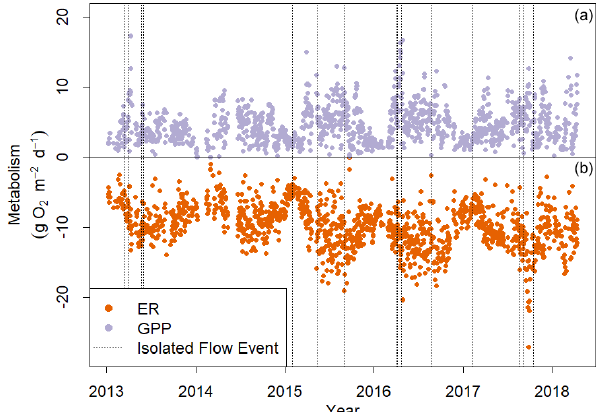
Figure 4. Gross primary production (GPP, a ) and ecosystem res- piration (ER, b ) in Stroubles Creek, VA, from 8 January 2013 to 14 April 2018. ER is represented here as a negative rate because it is the consumption of oxygen. Dashed vertical lines mark the isolated flow events that fit our criteria for analyzing metabolic responses to flow change (Fig. 2).